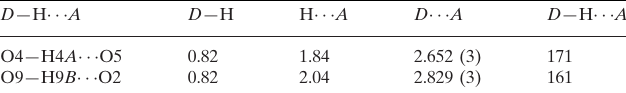
Hydrogen-bond geometry (A˚ , (cid:3)